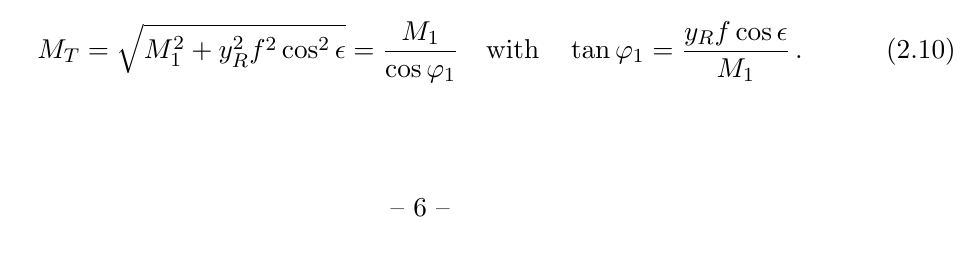
; M ) plane (left) and ( (cid:20) T ; M ) R B T